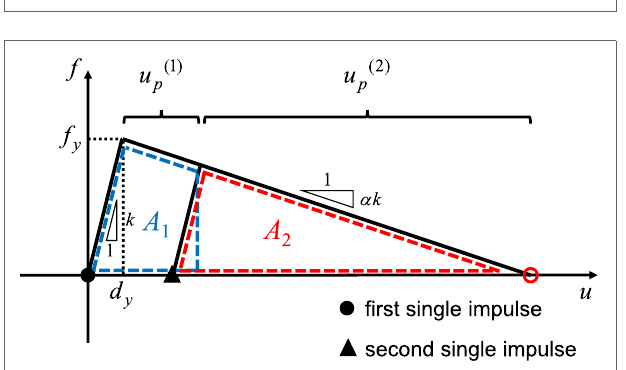
FIGURE 5 | Collapse scenario under two impulses and energy consideration for evaluating limit input velocity .